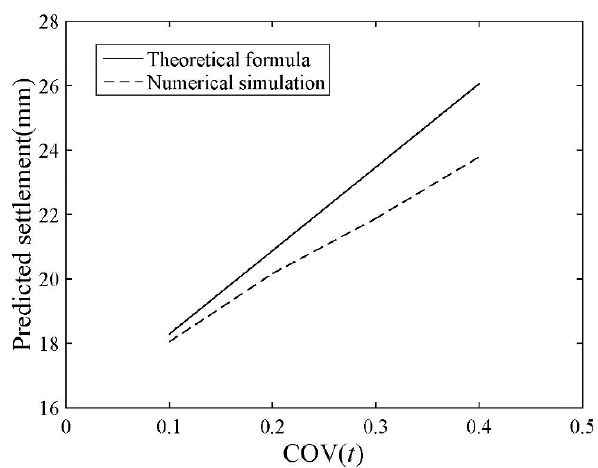
Figure 11. Predicted curve for ground-surface settlement.